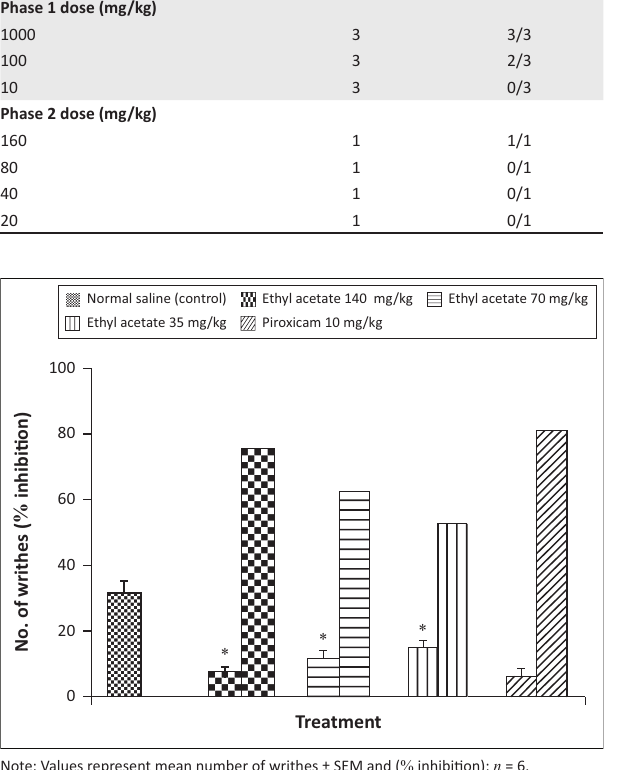
FIGURE 3: Effect of oleanolic acid on acetic acid-induced writhing in mice.